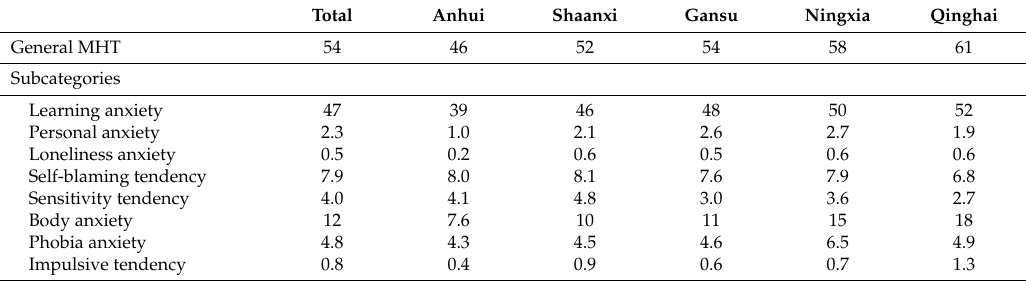
Table 2. Percentage of students at risk for anxiety across provinces.